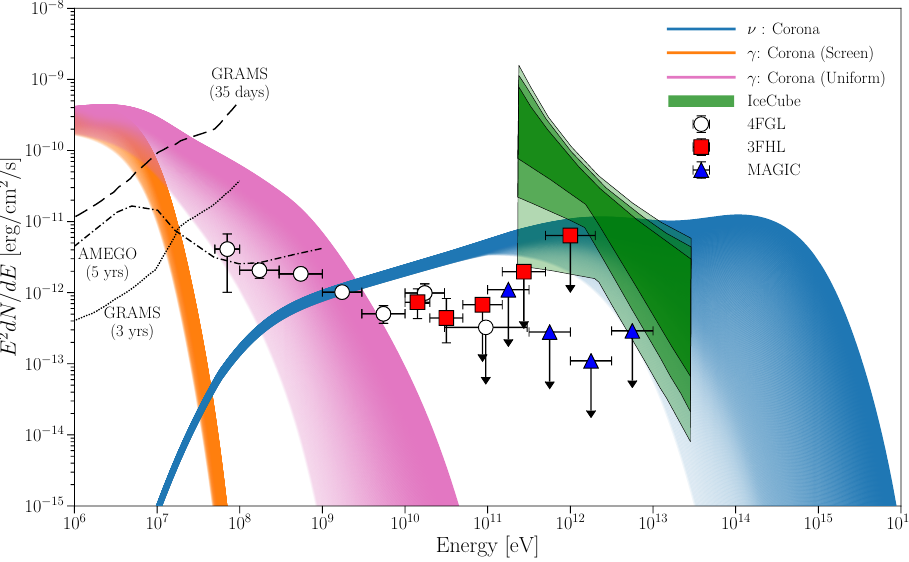
Figure 11. The Gamma-ray and neutrino spectra of NGC 1068. The circle, square, and triangle data points are from The Fermi-LAT collaboration [135], Ajello et al. [136], and Acciari et al. [16], respectively. The green shaded regions represent the 1, 2, and 3 σ regions on the spectrum measured by IceCube [8]. The expected Gamma-ray and neutrino spectra from the corona are shown for η g 30 3 10 4 . The darker region corresponds to lower η g . The blue region shows the expected ≤ ≤ × neutrino spectrum. The orange and magenta shaded region shows the Gamma-ray spectra for the uniform case and the screened case, respectively. Taken from Inoue et al.